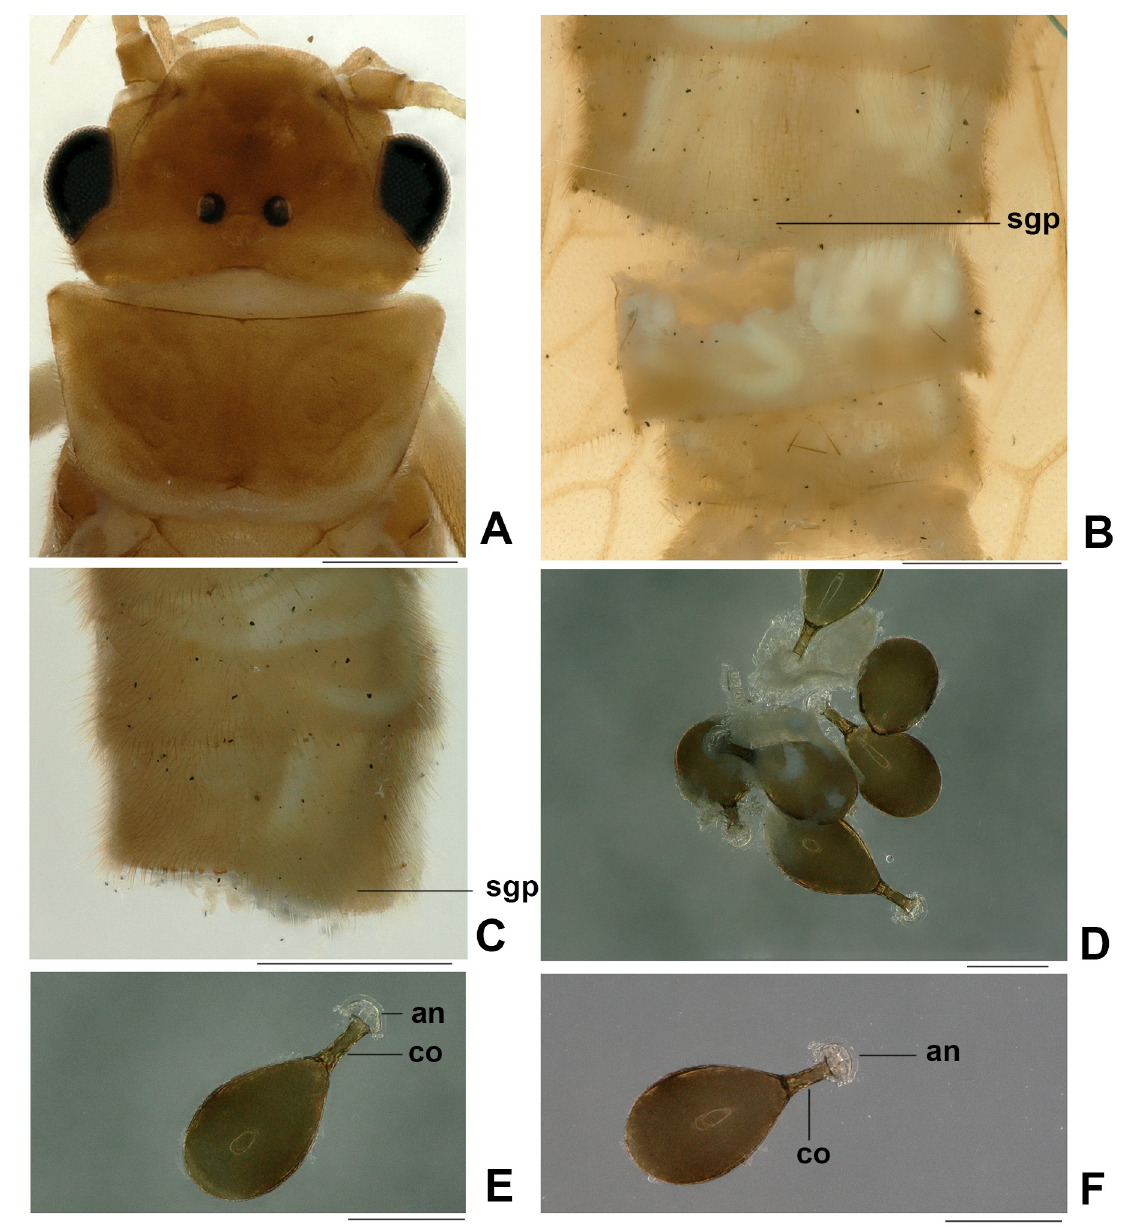
Fig. 13. Chinoperla gorohovi Sivec & Stark, 2010, ♀ (CAU). A . Head and pronotum, dorsal view. B . Terminalia, ventral view. C . Terminalia, lateral view. D . Eggs. E . Entire egg, lateral view. F . Entire egg, oblique lateral view. Abbreviations: see Material and methods. Scale bars: A–C = 0.5 mm; D–F = 0.25